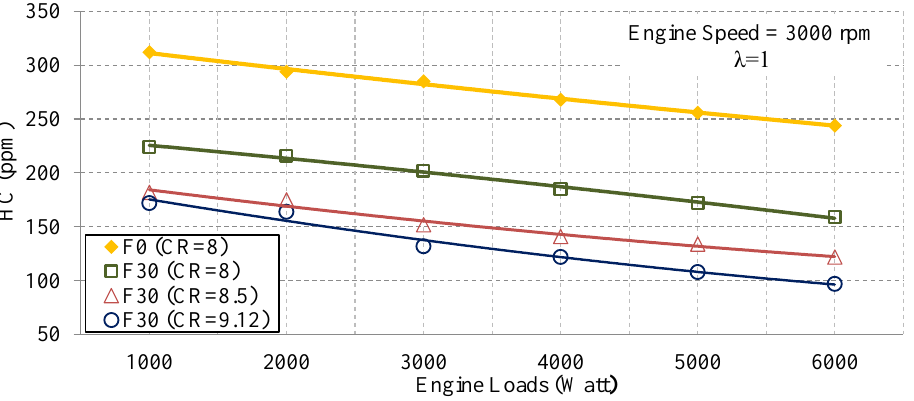
Figure 11. Hydrocarbon (HC) graph for F0 and the F30 blend at different compression ratios.